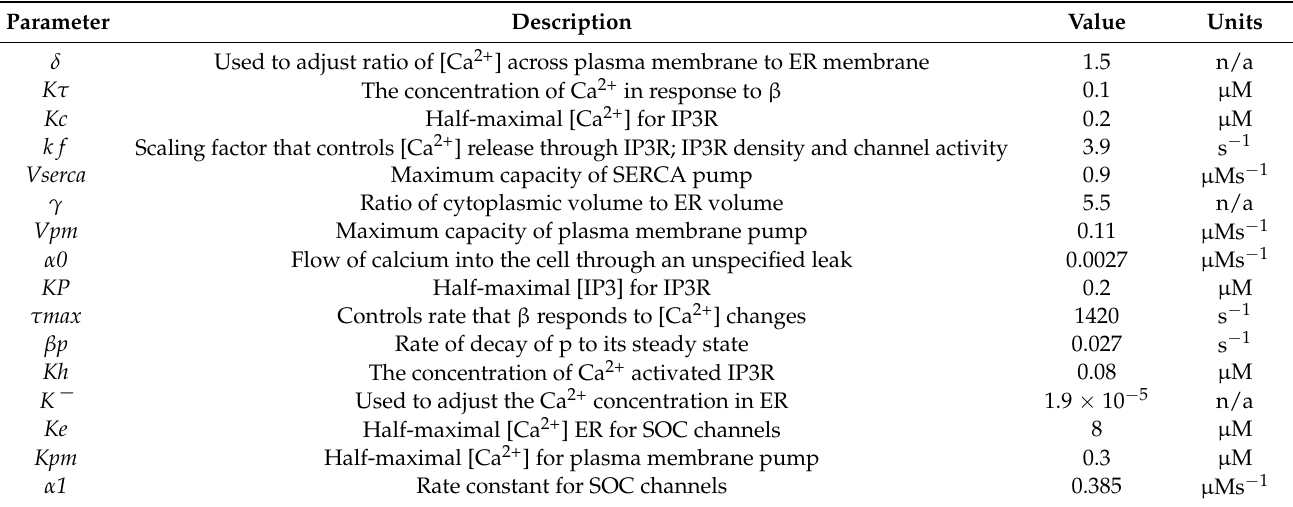
Table 2. Parameter values for the mathematical